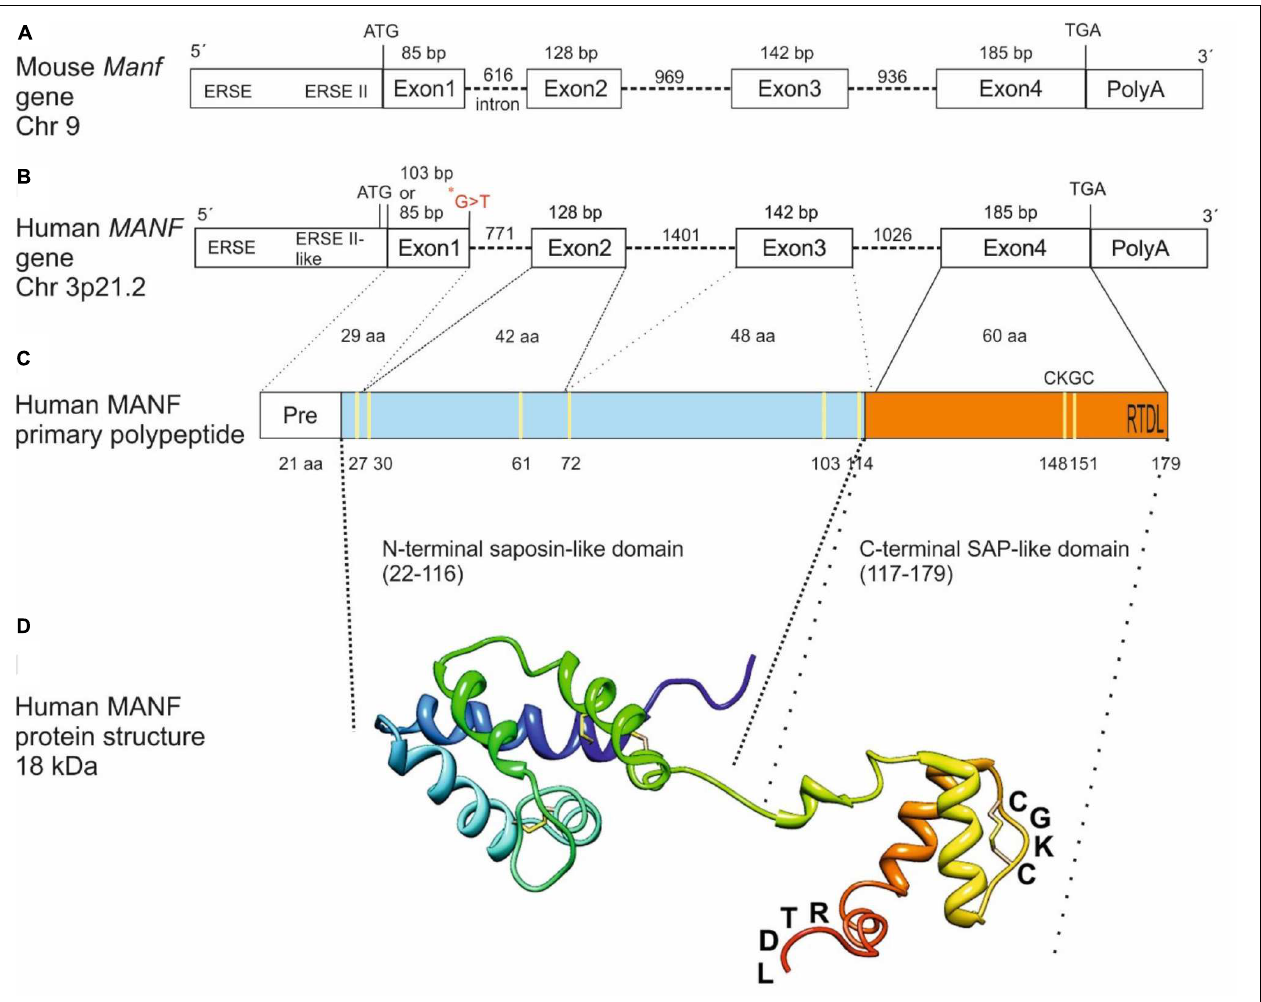
FIGURE 1 | From gene to protein. Schematic structure of mouse (A) and human (B) MANF genes with 4 exons, primary polypeptide structure (C) and NMR solution structure of human MANF protein (D) with an N-terminal saposin-like domain (aa 22–116, light blue) and a C-terminal SAP-like domain (aa 117–179, orange). ∗ G > T, homozygous missense mutation in a human patient with T2D (Yavarna et al., 2015) (B) . Cysteine residues are marked in yellow (C) . CXXC-motif and RTDL ER retention signal are indicated (C,D) . bp, base pair; Chr, chromosome; aa, amino acid; ERSE, ER stress-responsive element. Image in (C) modified from Lindahl et al. (2017) and in (D) from Hellman et al. (2011) and Lindstrom et al.